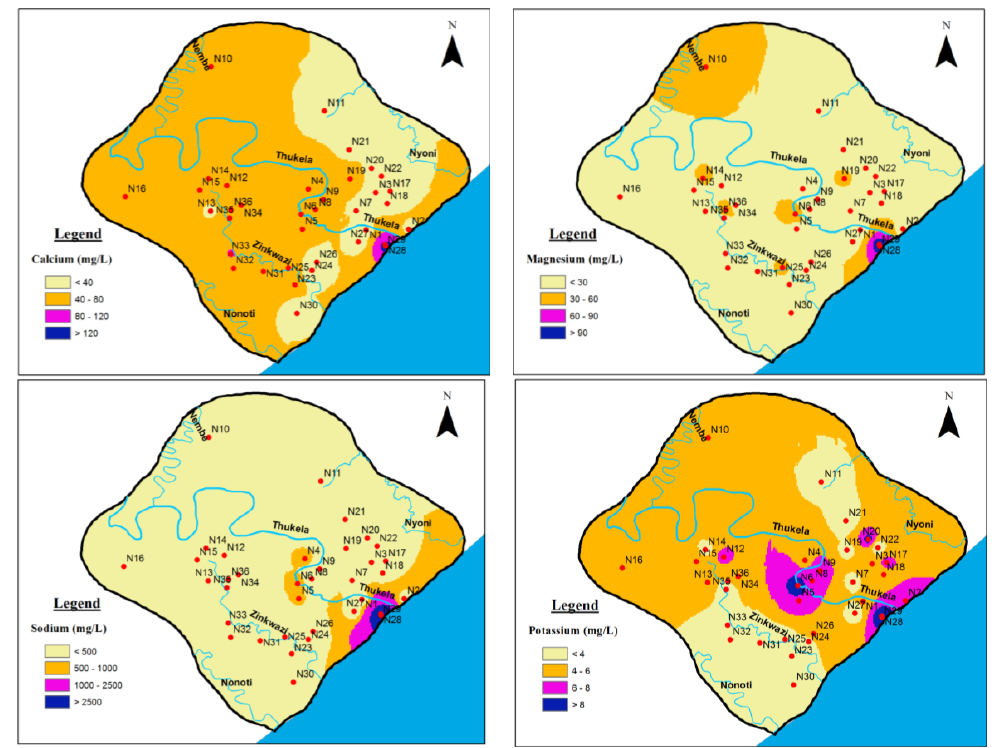
Figure 4. Spatial distribution of major cations.